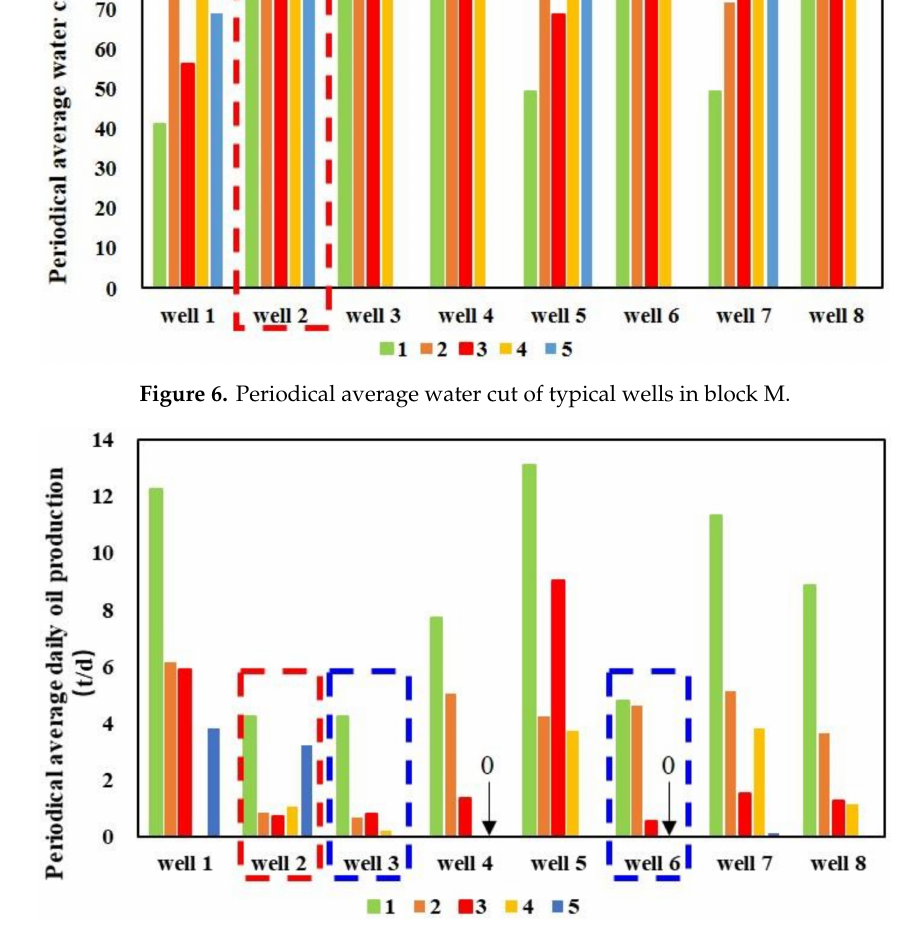
Figure 7. Periodical average daily oil production of typical wells in block